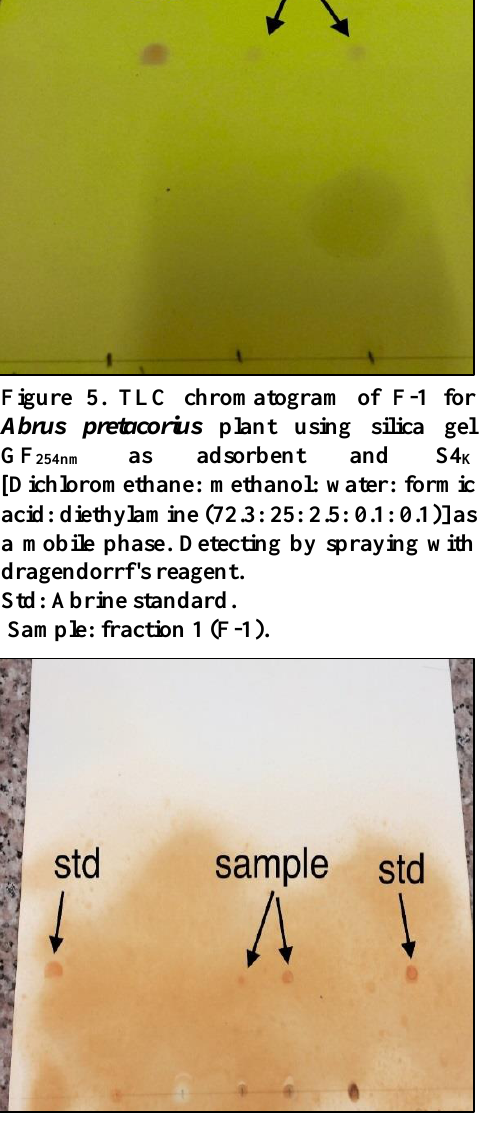
Figure 6. TLC chromatogram of (F-1) for Abrus pretacorius plant using silica gel GF 254nm as adsorbent and S5 K [Toluene: ethyl acetate: diethyl amine (70: 20: 10)] as a mobile phase. Detecting by spraying with dragendorrf's reagent. Std: Abrine standard.